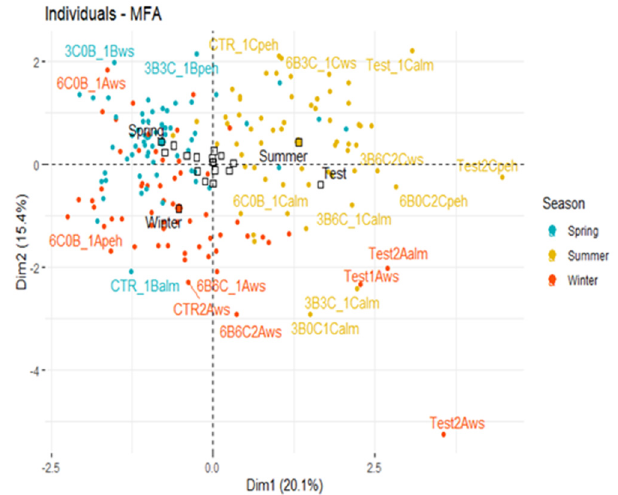
Figure 4. MFA of P. vaginatum physiological and stomatal parameters during three seasons. ( a ) Under two different water conditions, five groups of different factors were characterized for P. vagina- tum under two water shortages (20 and 60% of WHC). ( b ) Variable loading plot of the two first principal components.